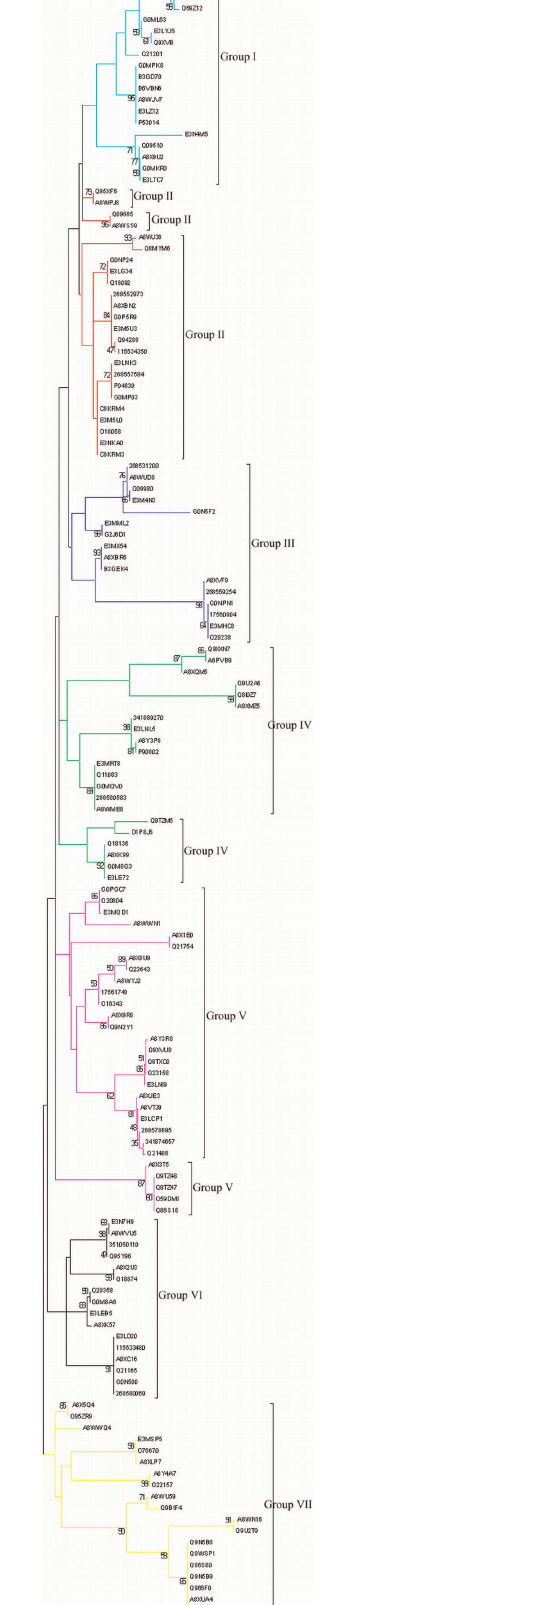
Figure 4. Phylogenetic tree to show the overall relatedness of the EF-hand proteins. All EF-hand proteins were aligned using MAFFT and analyzed using maximum likelihood method in MEGA5. Numbers represent the bootstrap values of 1000 replicates. The expanded groups are shown in Figures 5–11.